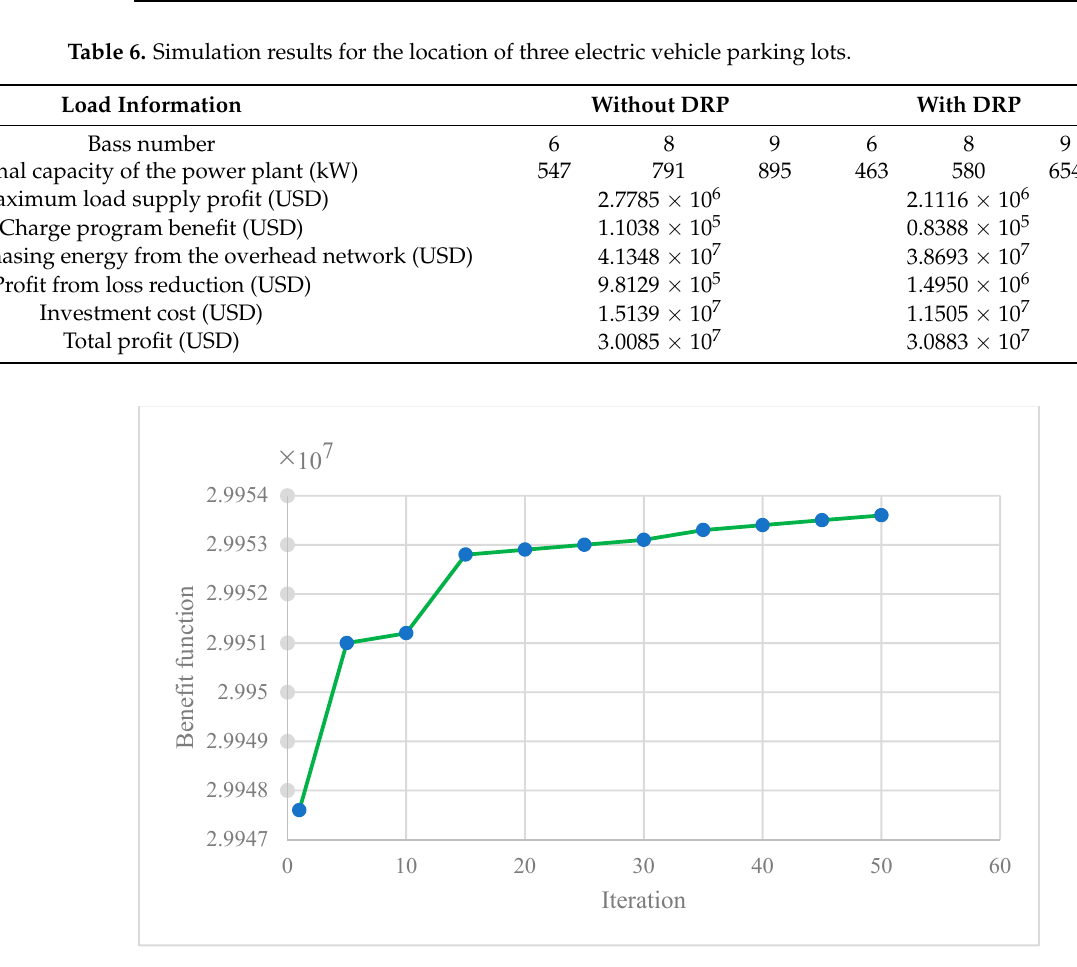
Figure 9. Cost function changes for parking location in different optimization periods. Table 4. Simulation results for the location of an electric vehicle park.